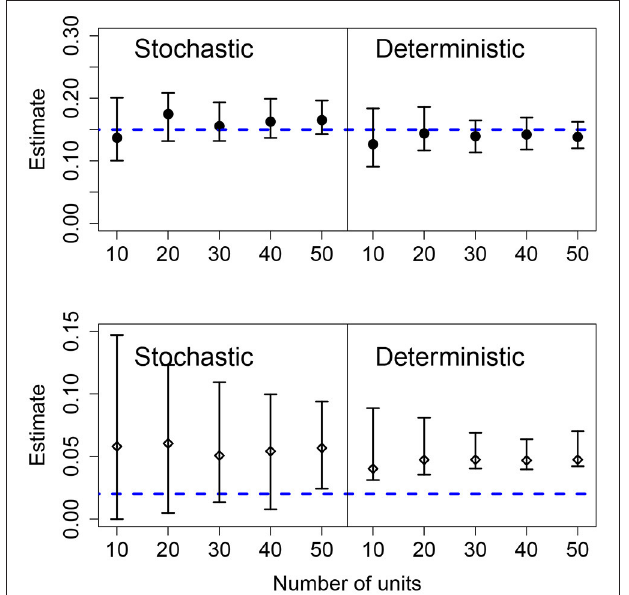
FIGURE 4 | Results of fits when there is a variable number of units. The data in all cases was generated by a pure birth process with parametric variability and fit with a birth-only model. The top row shows the estimates for the mean growth rate with stochastic or deterministic fits, and the bottom row the estimate of the standard deviation of the growth rate. The horizontal dashed blue lines indicate the parameter values used in the data generation. The vertical whiskers are the 95% CI obtained in the fits. In each case, the number of observations per unit was O = 20, the growth rate was α = 0.15 and the standard deviation of the growth rate was σ = 0.02.